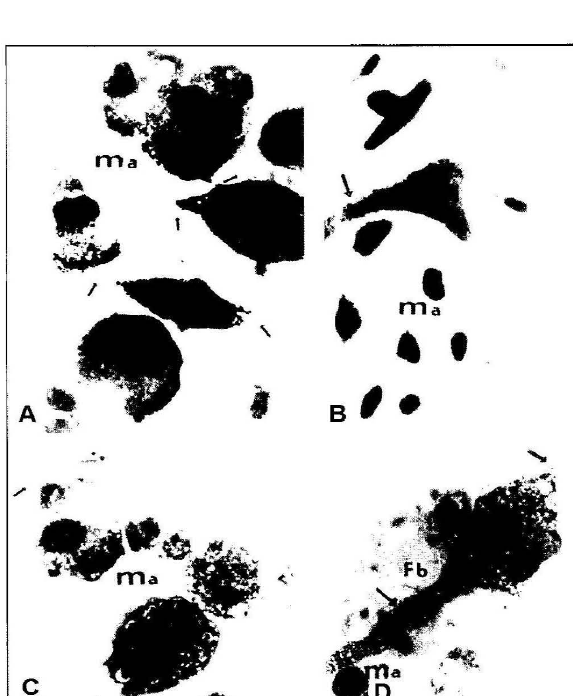
Figure 4. Bone marnnv stromal cells stained in the bonom of the flask in the long term bone marrow cultures, treated in vitro b~' 25 flg/ml ranopterin-neopterin (A, B, D) and b\' 50 flg/ml (C): Ma-macrophages differing in size and degree of cell activation (A-C) and with apoptotic nuclei (C-arrowheads); intercellular (FN-) matrix (A-arrows); tlbroblast-like cell with a long cytoplasmic dentrit-like uropode (D - arrow). Staining by the method of Zvetkova and Zvetkov, (ref. 99;